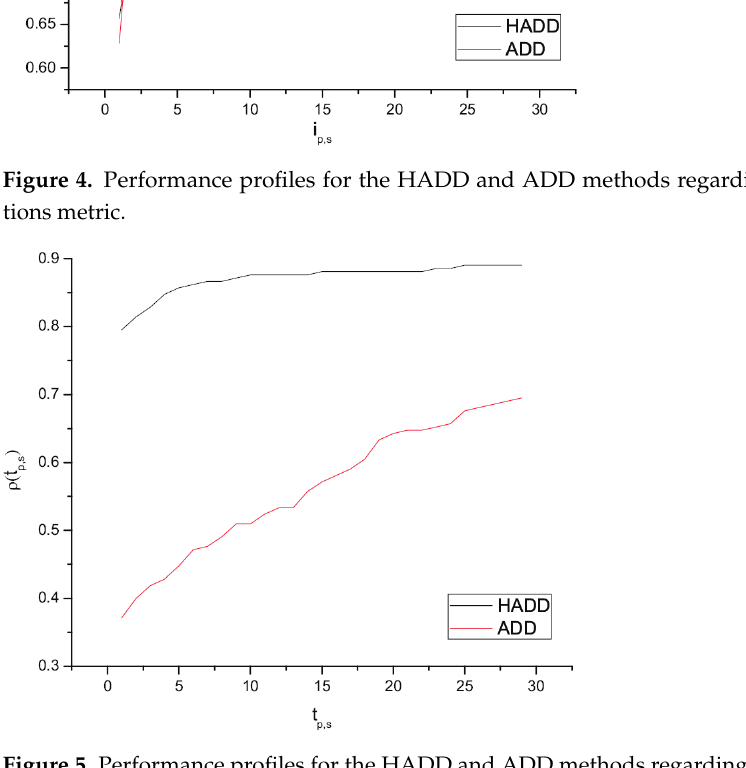
Figure 5. Performance profiles for the HADD and ADD methods regarding the CPU time metric.